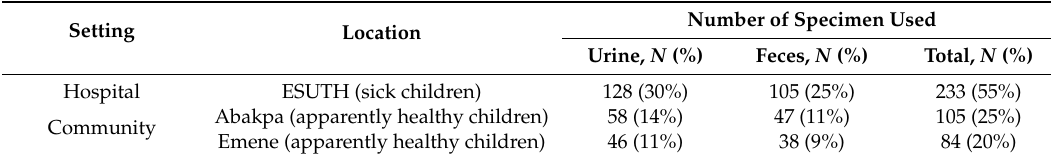
Table 1. The distribution of samples used for this study.